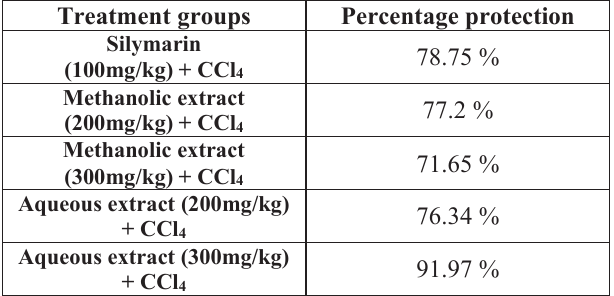
Table-3: Percentage protection of silymarin and T.